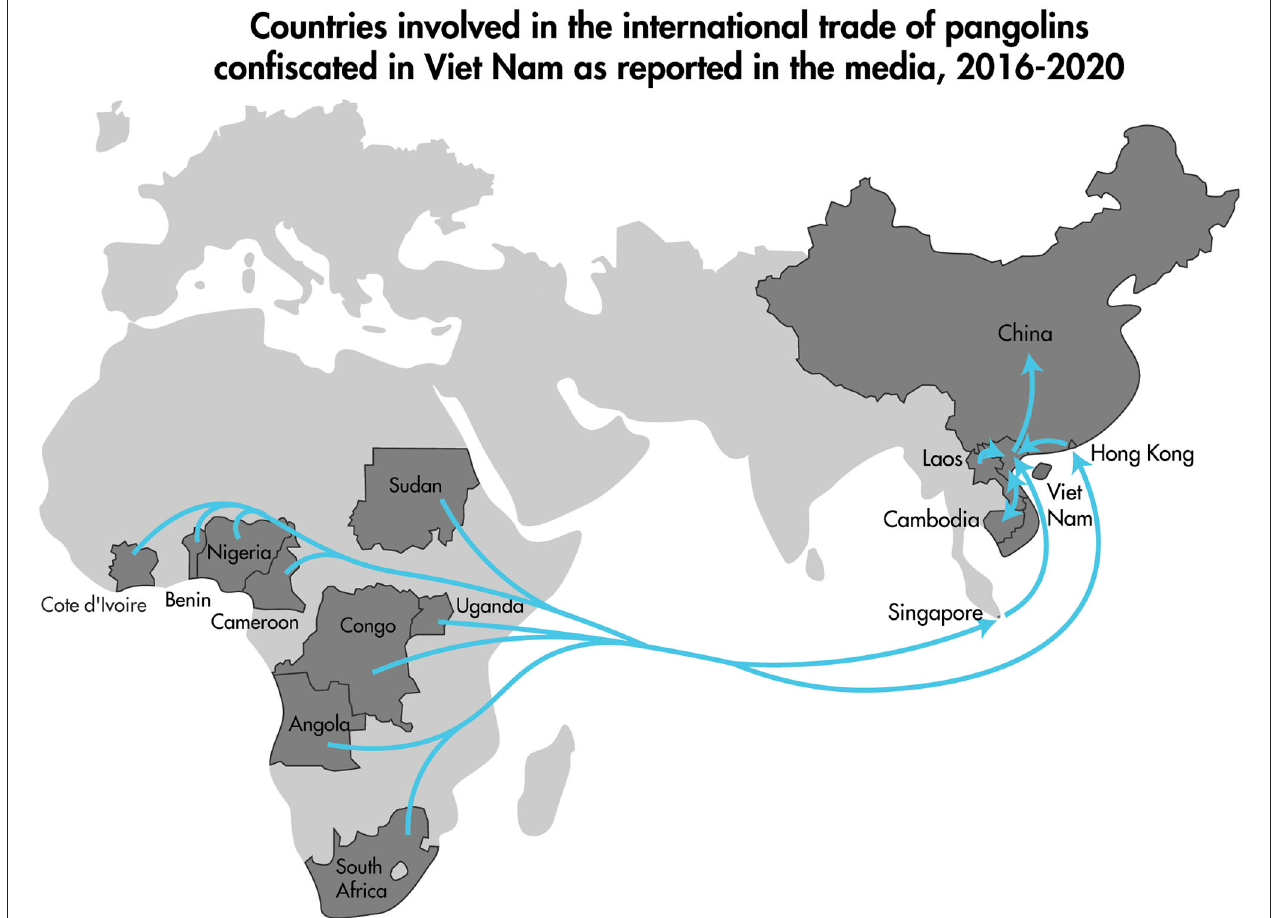
FIGURE 6 | Map highlighting the countries identified in reports of trafficked pangolins confiscated in Viet Nam (labeled darker gray countries) covered in the media between January 2016–December 2020. The arrows depict the generalized direction of trade from Africa (mainly pangolin scales), and from Southeast Asia (mainly live pangolins and carcasses) to China.